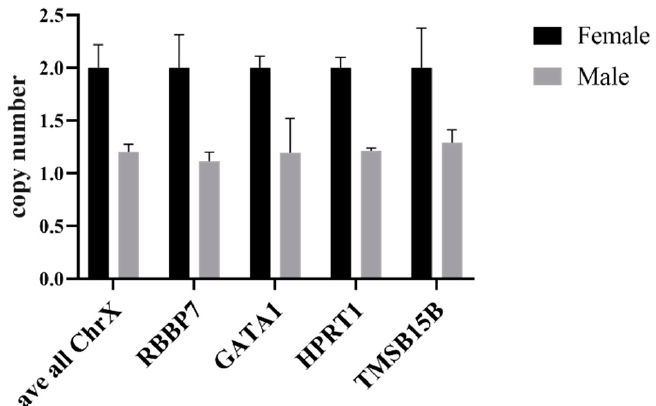
Figure 5. qPCR analysis of ChrX genes in female and male samples. Change in copy number calculated using the ∆ Ct method in ChrX normalized to autosomal gene CHOP. Values displayed as mean ± SD, n = 3.